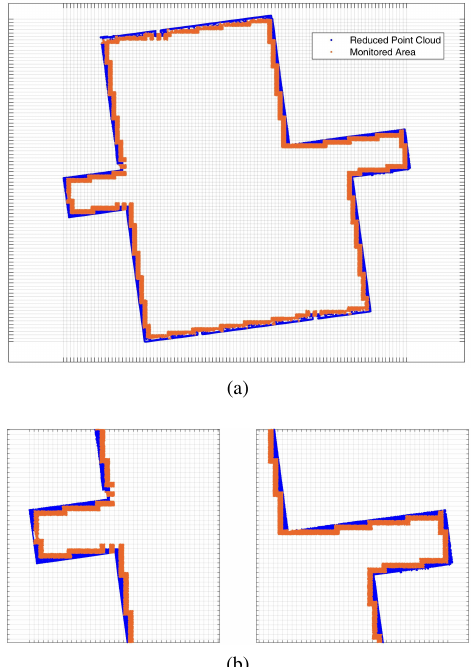
Figure 6: Reduced point cloud and monitored area for l s = 15 cm: (a) overview, (b)